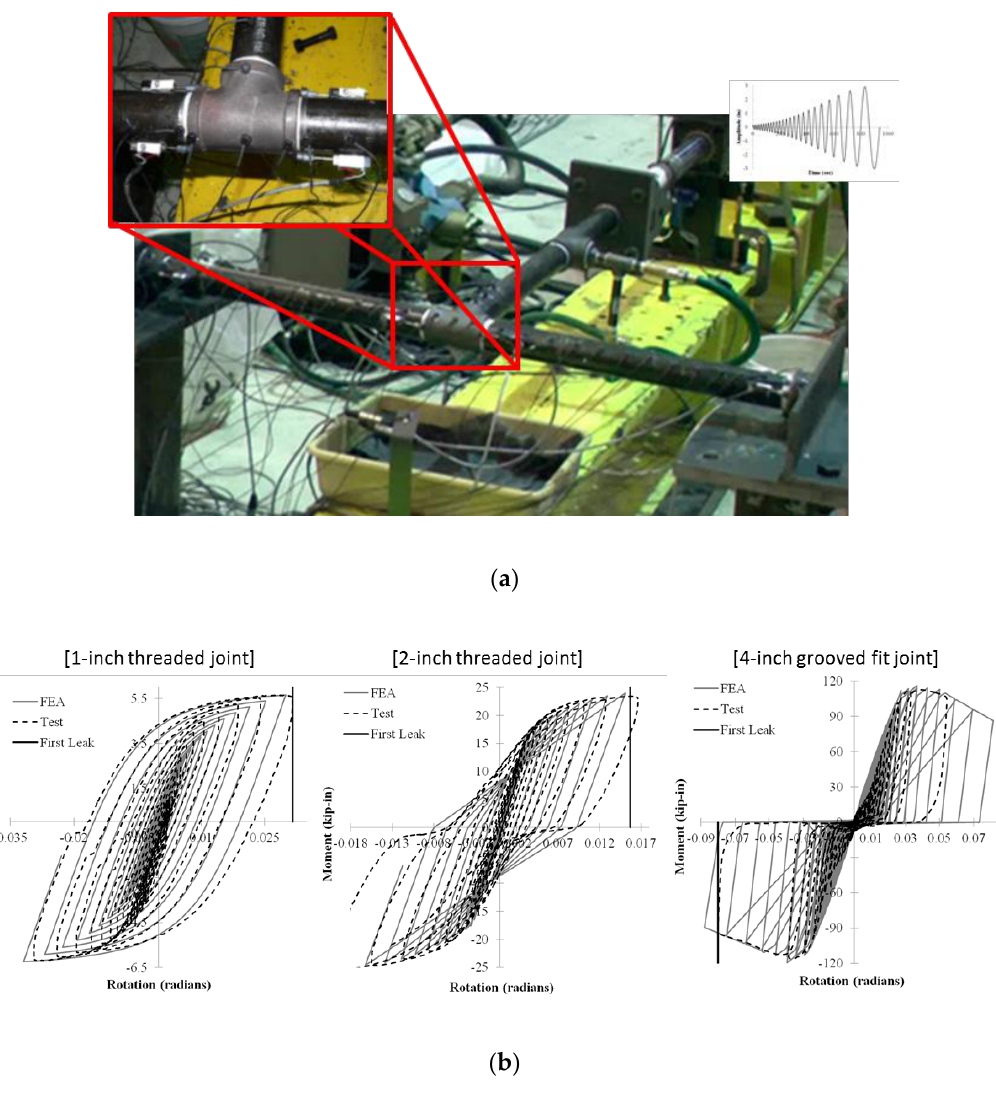
Figure 5. Piping T-joint numerical model validation: ( a ) dynamic cyclic test of 2-inch piping T-joint component; ( b ) 1-inch, 2-inch and 4-inch joint numerical model verification results.